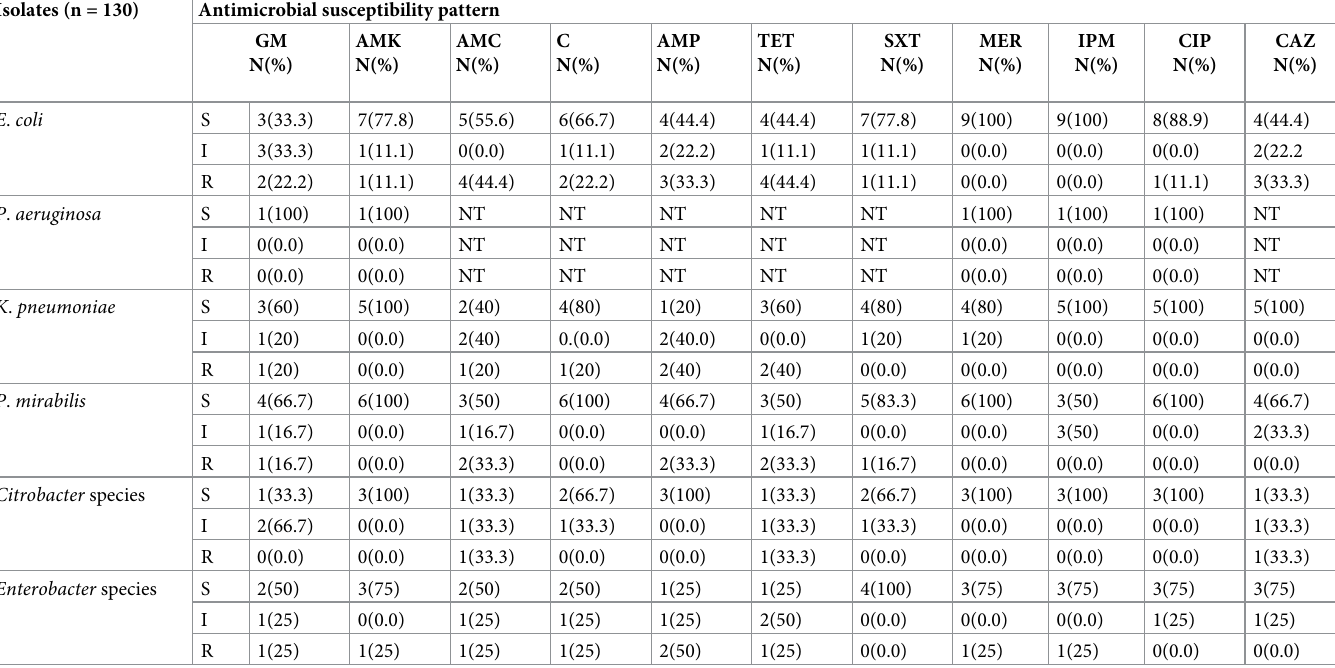
Table 4. Antibiotic susceptibility pattern of culture-confirmed Gram-negative bacterial isolates from EOI patients at DMCSH, Northwest Ethiopia, 2021. Isolates (n = 130)